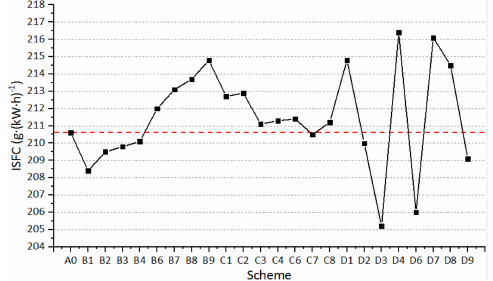
Figure 45. ISFC of each optimized design scheme.